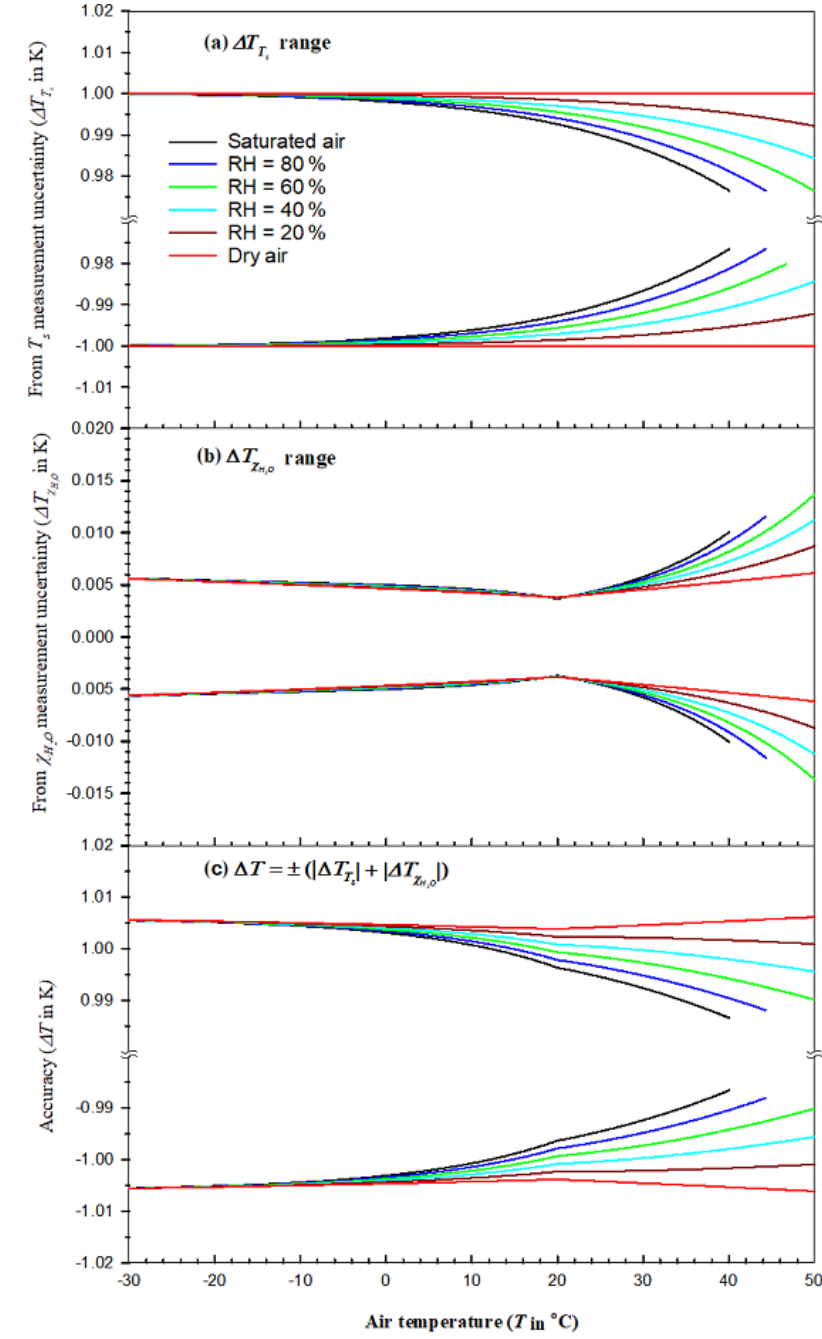
Figure 2. Accuracy of air temperature computed from Eq. (23) (equation-computed T ) over the measurement range of the H 2 O molar mixing ratio ( χ H ) within the operational range of T for the CPEC300 series (Campbell Scientific Inc., UT, USA): (a) accuracy component 2 O of equation-computed T due to sonic temperature ( T s ) measurement uncertainty, (b) accuracy component of equation-computed T due to χ H measurement uncertainty, and (c) overall accuracy of equation-computed T 2 O